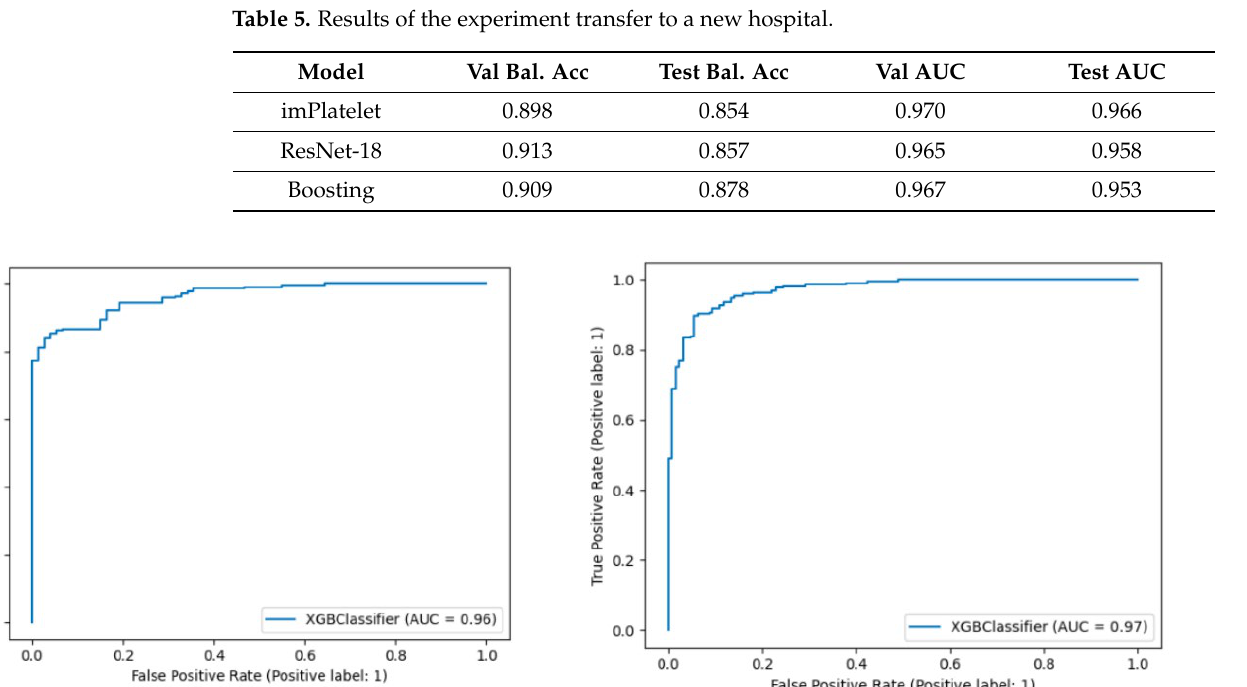
Table 4. Effect of permuting rows and columns of the images on the model performance.